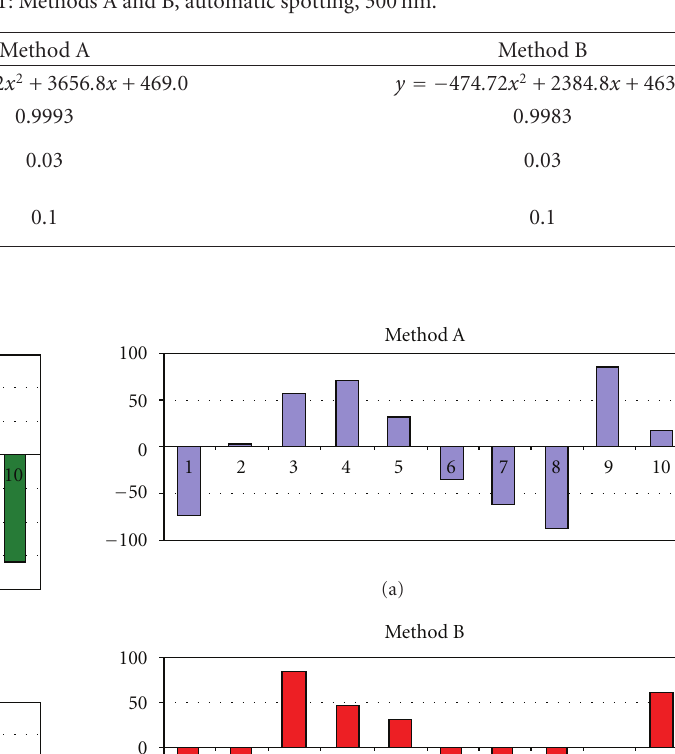
Table 1: Calibration plots for ET: Methods A and B, automatic spotting, 300 nm.